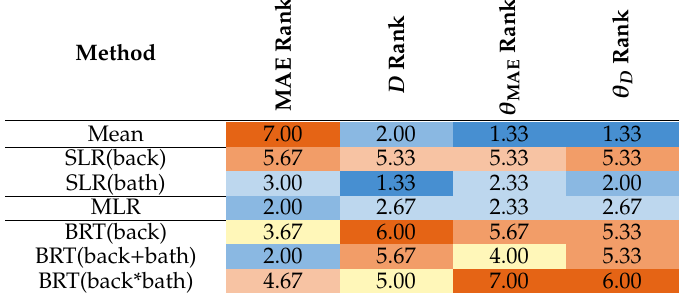
Table 3. Performance comparison of bulk shift methods at harmonizing Bedford Basin datasets from di ff erent years. Scores are average ranks relative to the other methods for each frequency. Ranks are colour-coded from blue to orange for best to